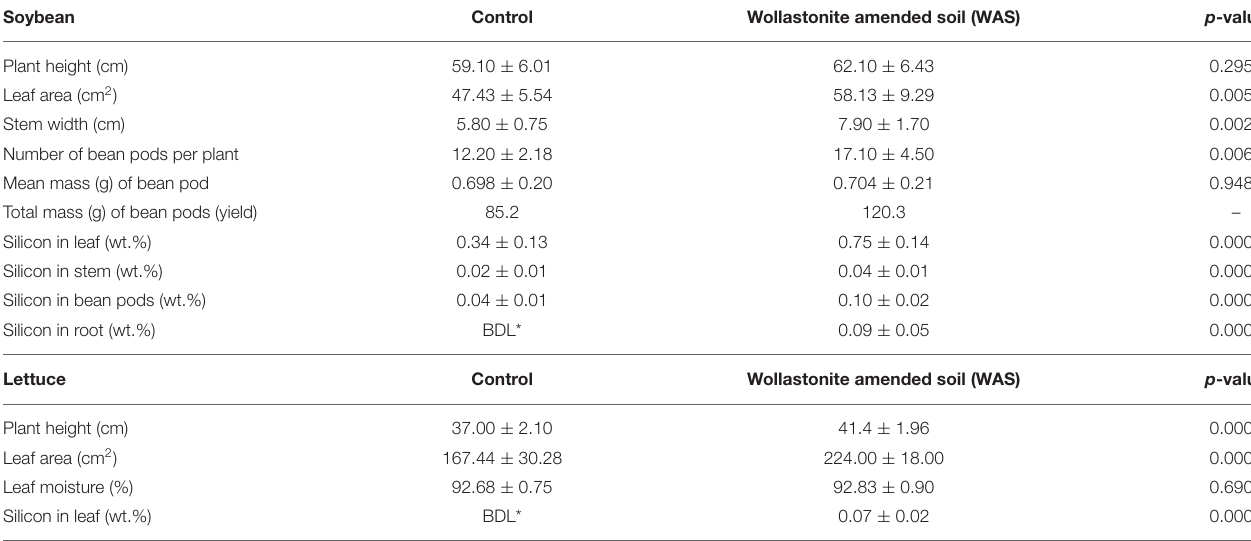
TABLE 1 | Effect of wollastonite skarn on soybean and lettuce growth. Soybean